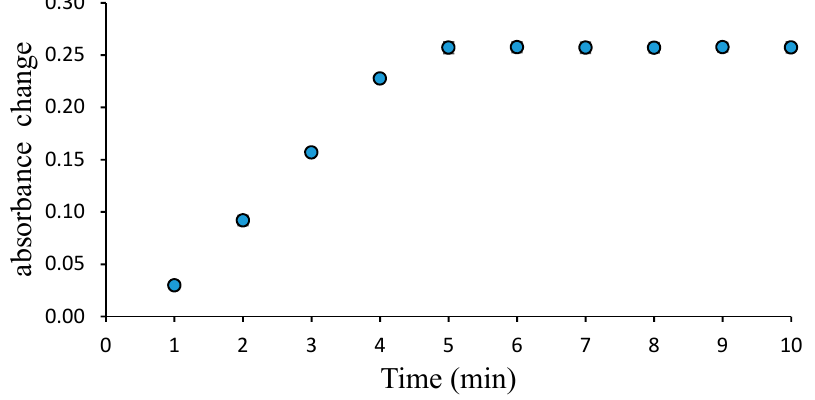
Figure 5. Pe/CI optical pH sensor response determined from 0.5 to 10 min. Figure 5. Pe / CI optical pH sensor response determined from 0.5 to 10